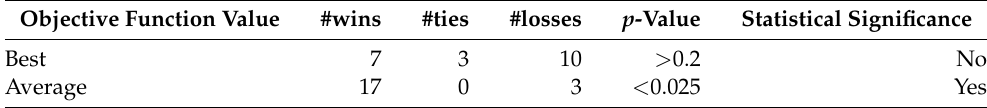
Table 4. Comparison of VNS2 vs. VNS1 for smaller sized instances. Objective Function